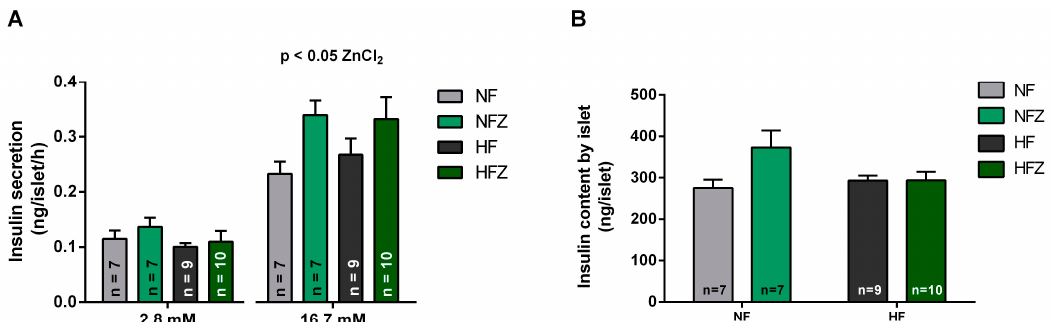
Figure 5. Glucose-stimulated insulin secretion (GSIS) and insulin content of isolated pancreatic islets. Effect of low (2.8 mM) and high (16.7 mM) glucose concentration in insulin secretion (ng/islet/h) ( A ). Islet insulin content ( B ). Two-way ANOVA of the insulin secretion by islets at 16.7 mM glucose (chow, p > 0.05; zinc, p < 0.05; interaction, p >